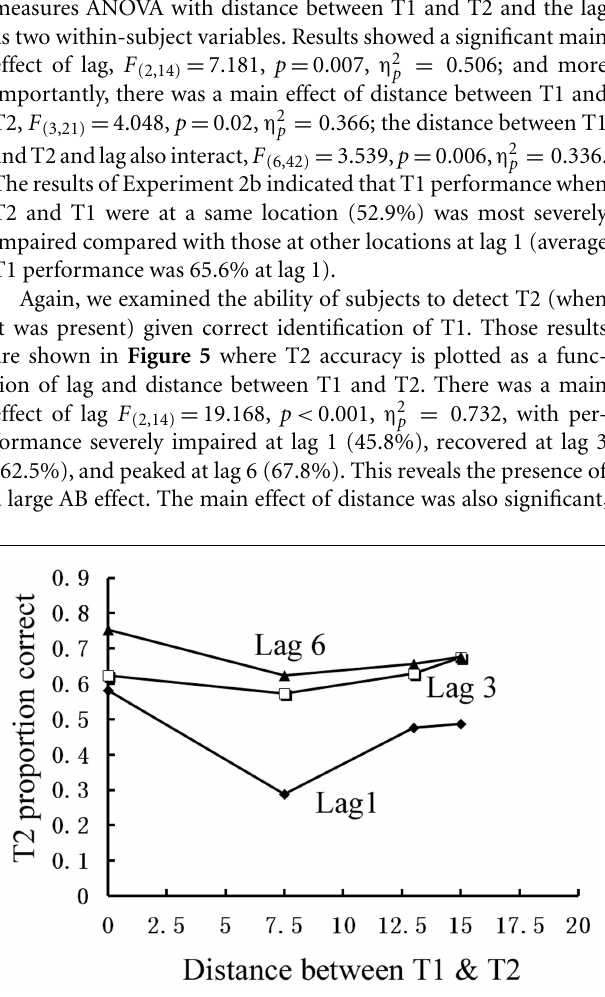
FIGURE 5 | Mean discrimination accuracy ofT2 when participants correctly reportedT1 in Experiment